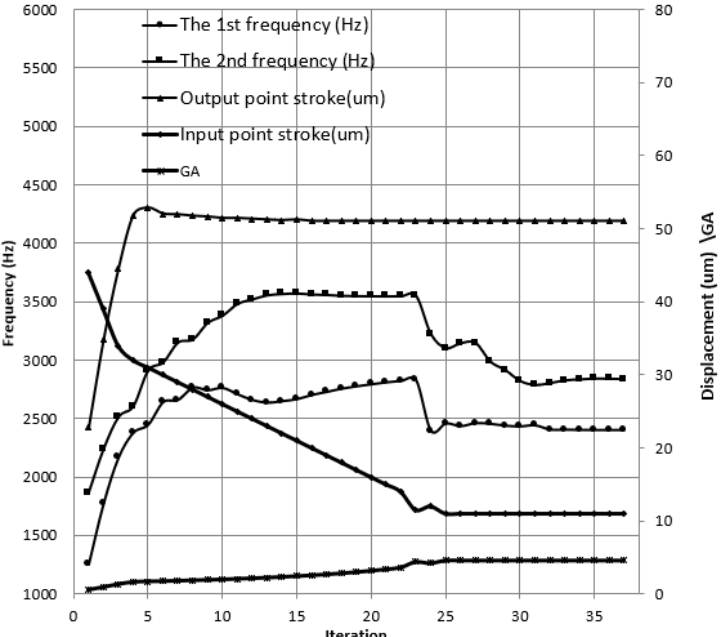
Figure 8. Convergence history of input and output strokes and eigenfrequencies for example 3 with weighting coefficient 2250 of the 1st eigen-frequency.